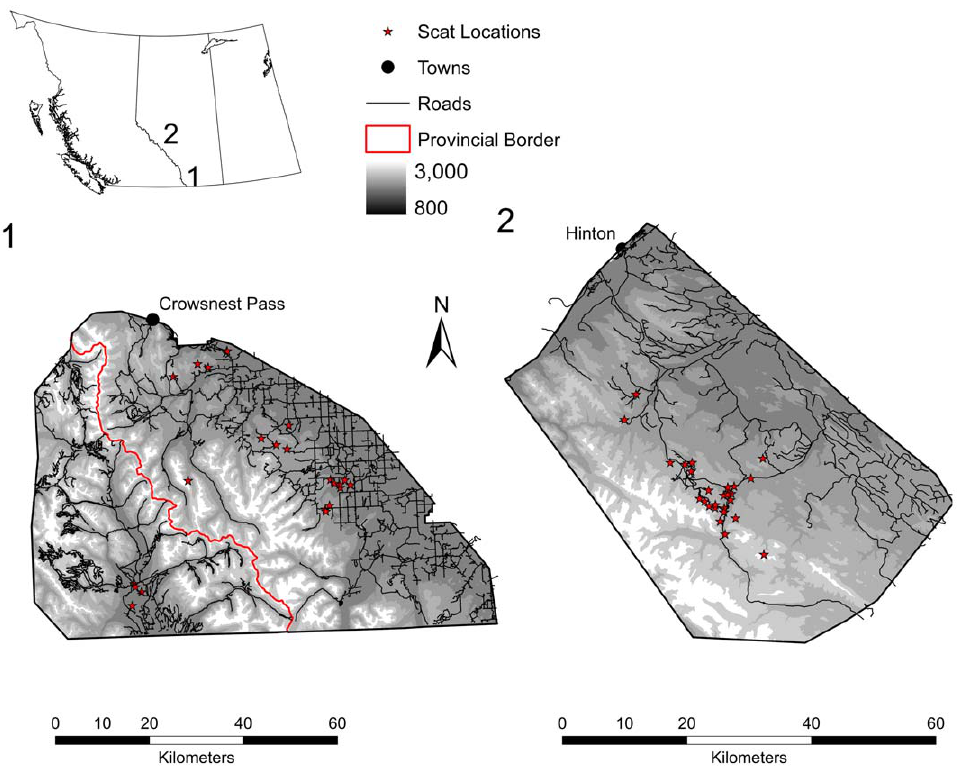
Table 1. Animals monitored in this study.